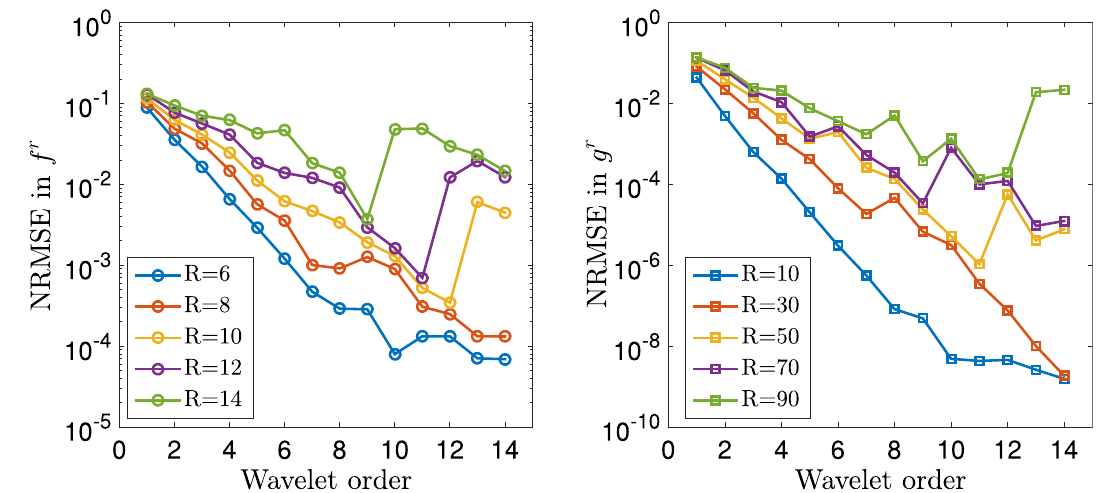
Fig. 6 Plots showing the NRMSE between the original and reconstructed datasets f r ( left ) and g r ( right ) plotted in Fig. 4 as a function of the wavelet order for different compression ratios, as indicated